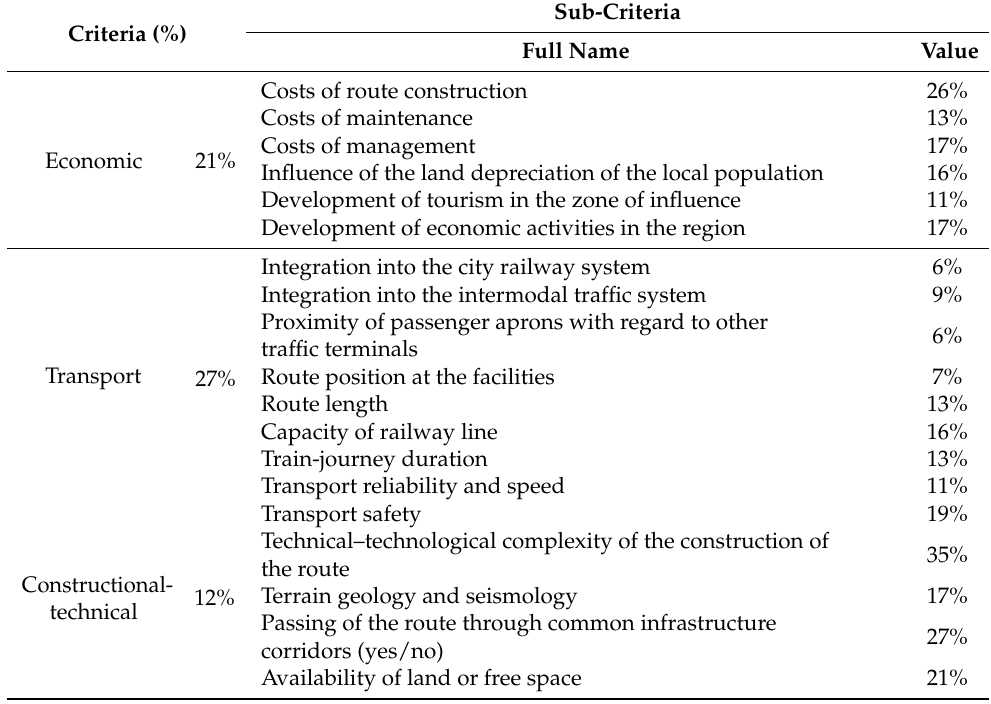
Table 1. Criteria and sub-criteria for evaluation and selection of a railroad route. Criteria